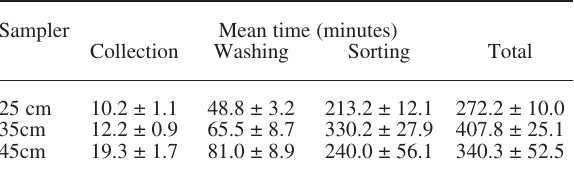
T ABLE 1. – Mean time taken for collection, washing and sorting of samples collected using the three different samplers (diameter 25, 35 and 45 cm). n = 6 for each sampler, and values stated are